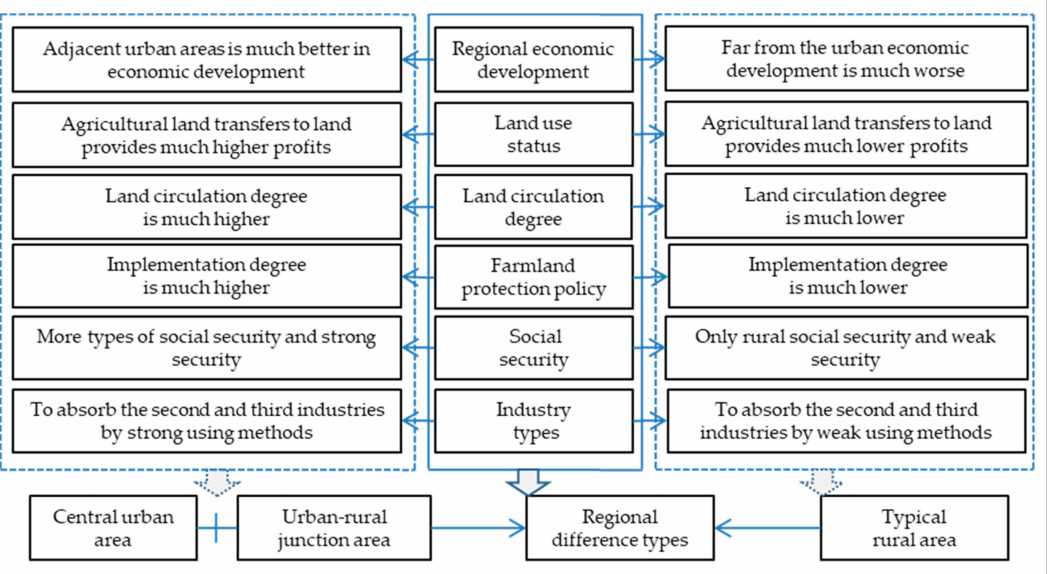
Figure 1. Regional di ff erences of the external environment in terms of ecological compensation for cultivated land protection